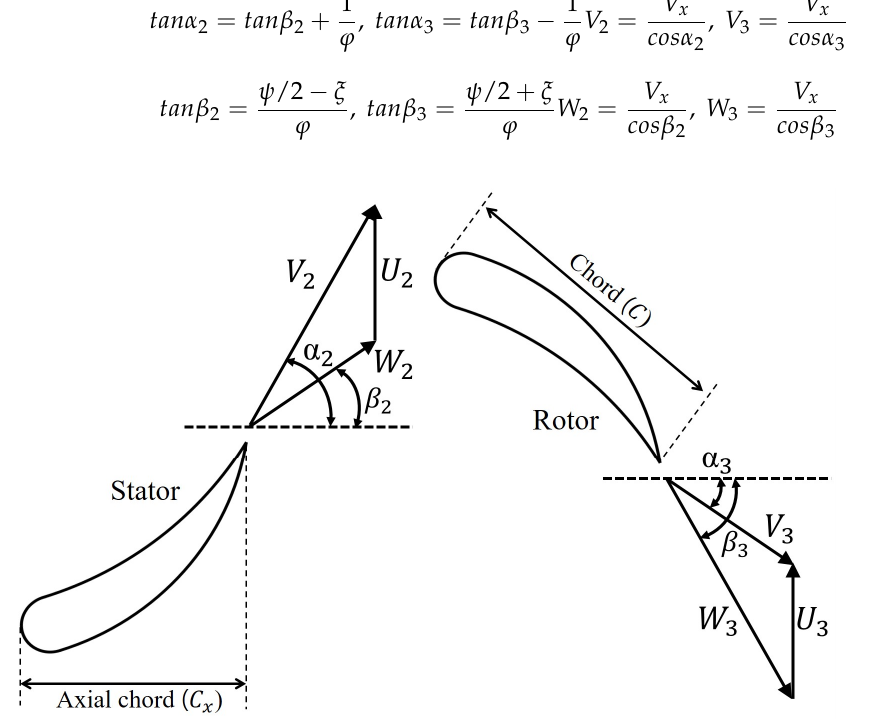
Figure 3. Turbine blade geometry and typical velocity triangle for the axial-flow turbine blades.